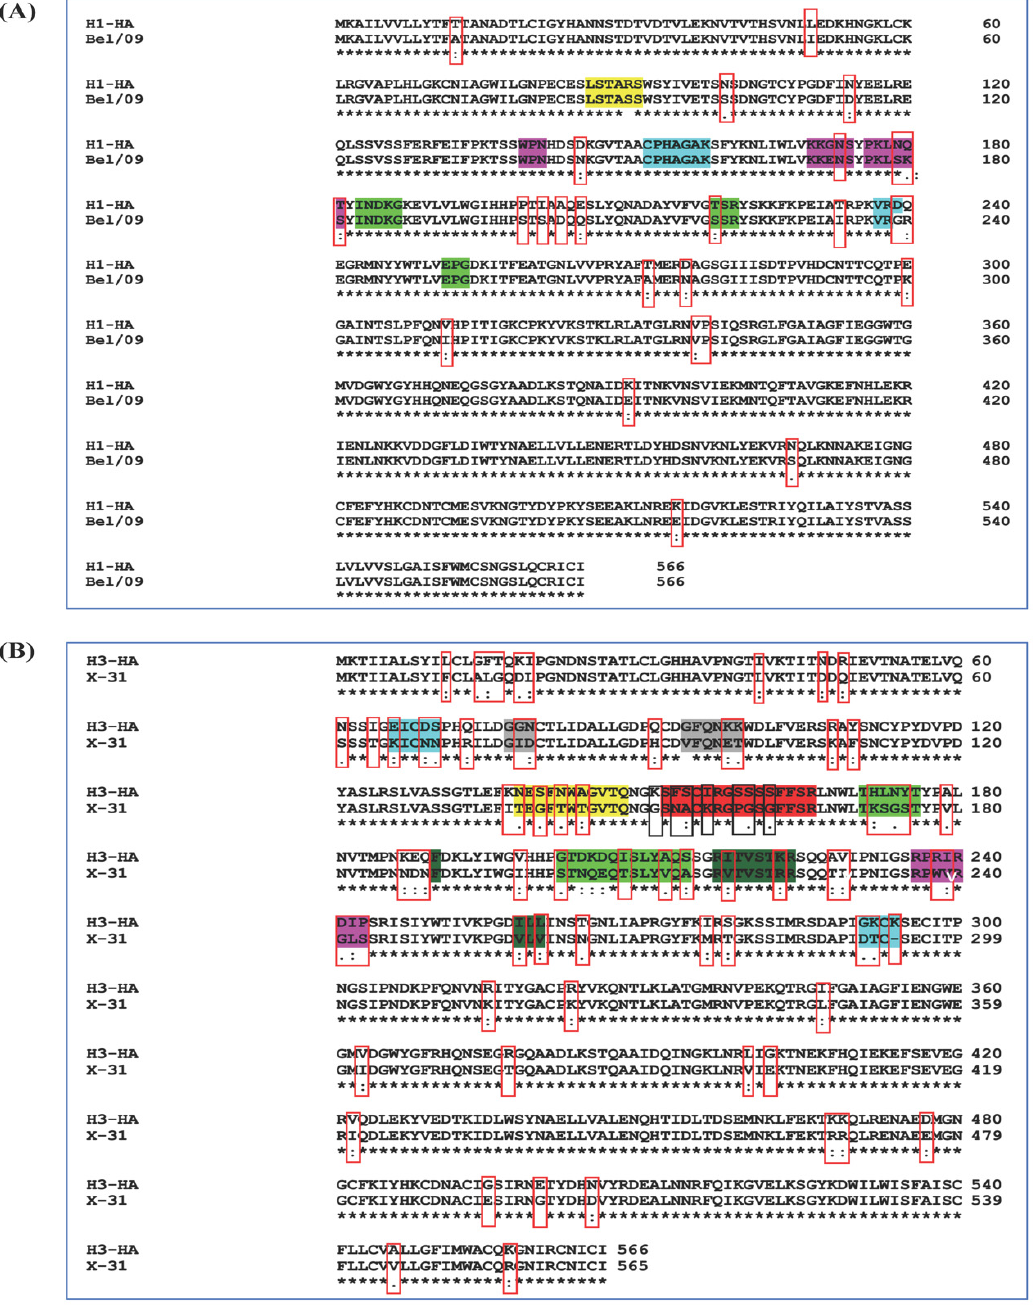
Figure 8. Hemagglutinin sequence alignment using Clustal Omega (1.2.4). ( A ) H1-HA sequence used in ectofusion immunogen design and in challenge virus (Bel/09) were aligned. Antigenic variations are boxed (red color) and antigenic sites are highlighted with different colors (Sa: magenta, Sb: yellow, Ca1: green, Ca2: cyan). ( B ) H3-HA sequence used in ectofusion immunogen design, and in challenge virus (X-31) were aligned. Antigenic variations are boxed (red color) and antigenic sites are highlighted with different colors (Site A: red, Site B: green, Site C: cyan, Site D: dark green, Site E: gray).